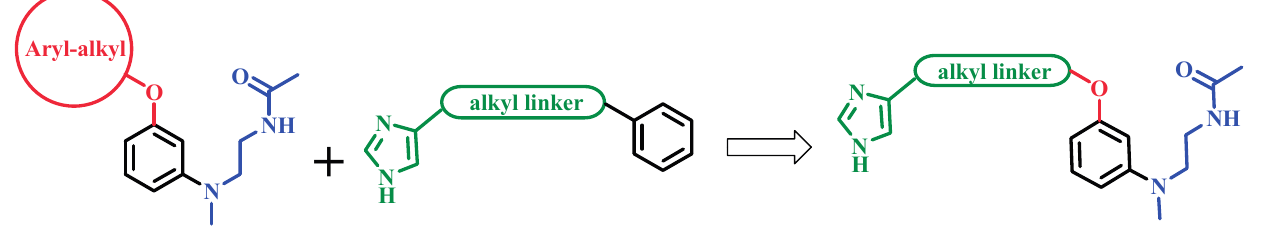
Figure 3. Schematic representation of the strategy followed in the design of dual melatonergic-H 3 receptor ligands.